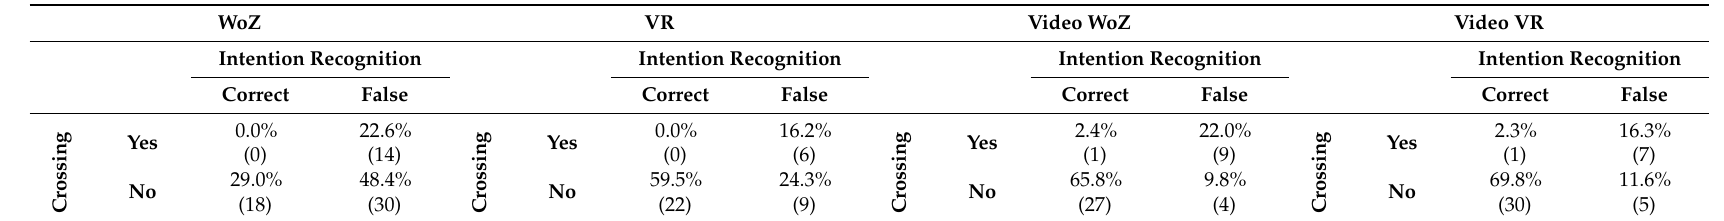
Table 7. Mentioned crossing behavior for the intention AV goes first, ambiguous